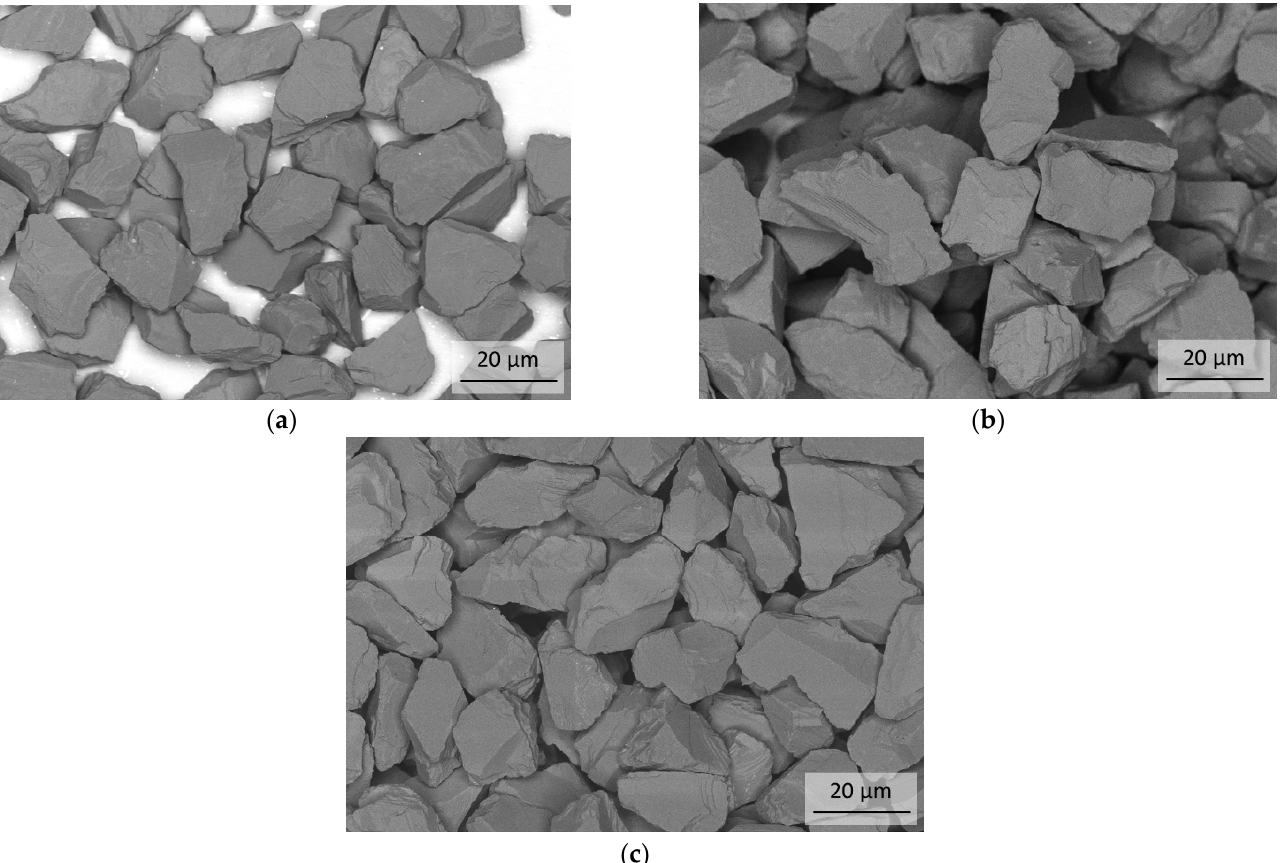
Figure 1. FESEM micrographs of the cBN powders in the initial state (as-received state); ( a ) cBN-B20; ( b ) cBN-B21; ( c ) cBN-C41.